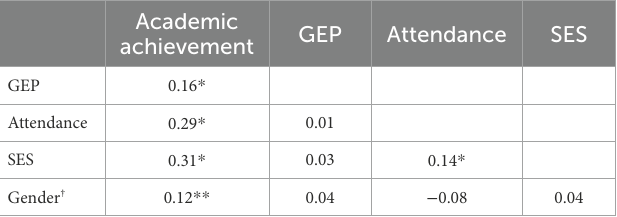
TABLE 2 Correlations between study variables.